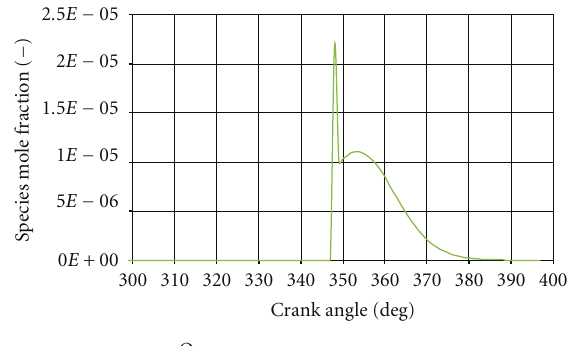
Figure 13: O radical formation (1400rpm; 25% load; 17.5 CR; 0% EGR).